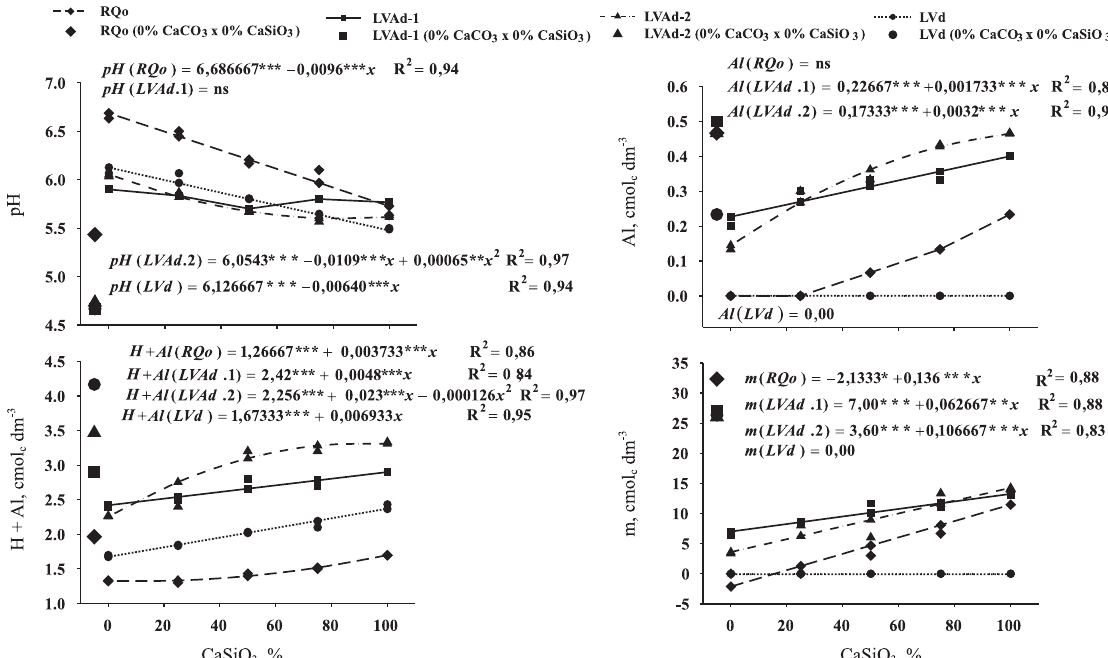
Figura 2. Influência da substituição do CaCO RQo, LVAd-1, LVAd-2 e LVd e solos sem correção. ***, **, * e ns: significativo a 0,1; 1 e 5 %, e não- significativo,